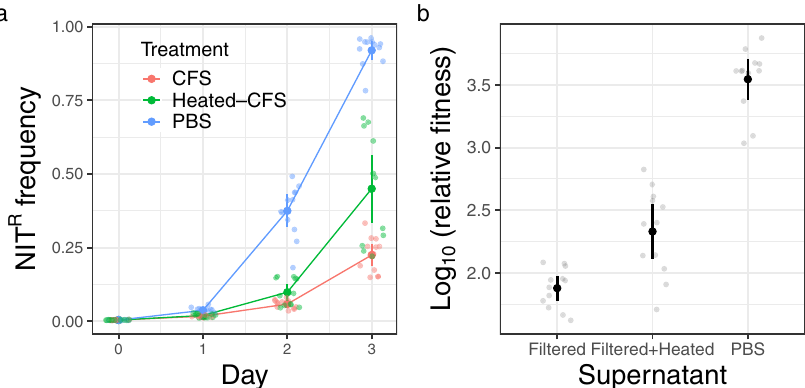
Fig. 3 Extracellular compounds from B. subtilis dampen NIT resistance enrichment. a Lines depict increase in the frequency of NIT R cells over 3 days at sub-MIC. Colors depict dynamics in the presence of either added PBS or cell-free supernatant (CFS) or heat-treated cell-free supernatant. b Depiction of log-transformed relative fi tness of NIT R cells after 3 days of competition with NIT S cells under three supernatant treatment regimes. The log-transformed relative fi tness value of zero represents no fi tness advantage to either NIT R or NIT S strains, while positive values indicate an advantage to NIT R strains. Lighter points depict individual replicates, darker points represent means and error bars represent 95% con fi dence intervals ( t -distribution, n = 12 for both